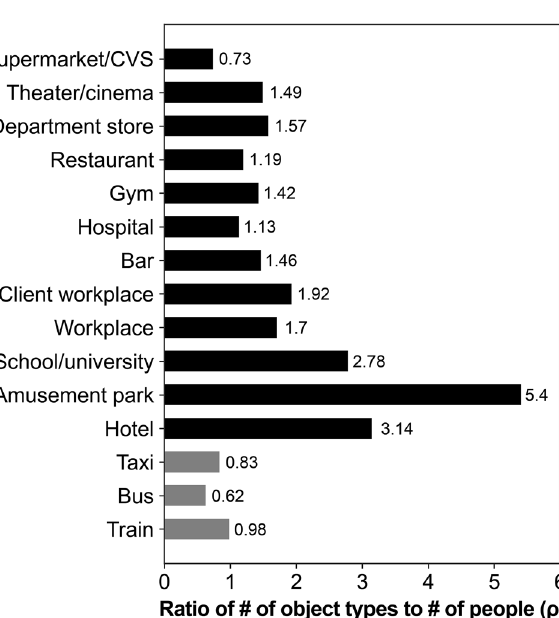
Figure 4. Heat maps of multiple comparisons of the number of contact objects at ( a ) each location and ( b ) each vehicle using the Scheffé test. To determine significant differences between groups in terms of the number of objects with which subjects came into contact at each location, a multiple comparison using the Scheffé test was conducted.